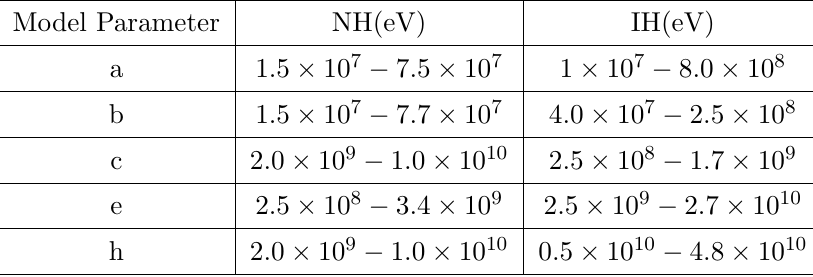
Table 4 . Allowed range of the model parameters satisfying DM